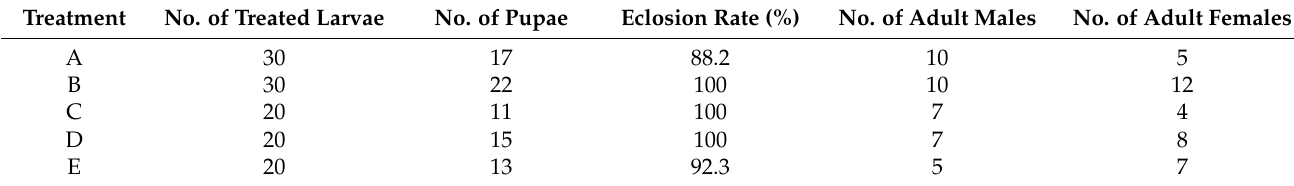
Table 2. Pupation and eclosion of lacewing in the five diet mixture treatments: (A) synthetic diet plus larval powder of beet armyworm (BAW) fed on transgenic cotton (GK-19); (B) synthetic diet plus larval powder of BAW fed on non-transgenic cotton (Simian-3); (C) synthetic diet plus synthetic Bt pro-toxin; (D) blank synthetic diet; and (E) aphid